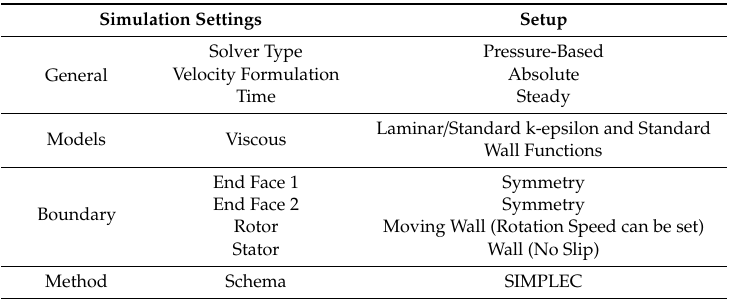
Figure 6. Comparison chart of theoretical results based on laminar flow theory and CFD simulation Figure 5. CFD simulation model. ( a ) Geometry of the air gap. ( b ) Radial grid of air gap. ( c ) Axial grid results under laminar state and turbulent state. of air gap.